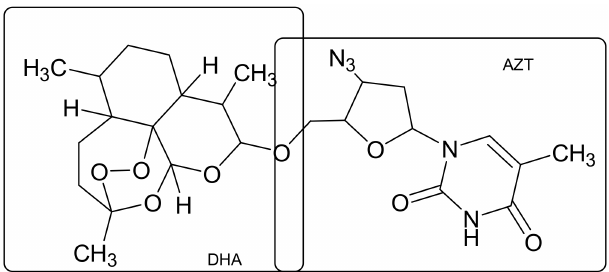
Figure 7. Azidothymidine-dihydroartemizine hybrid/codrug.